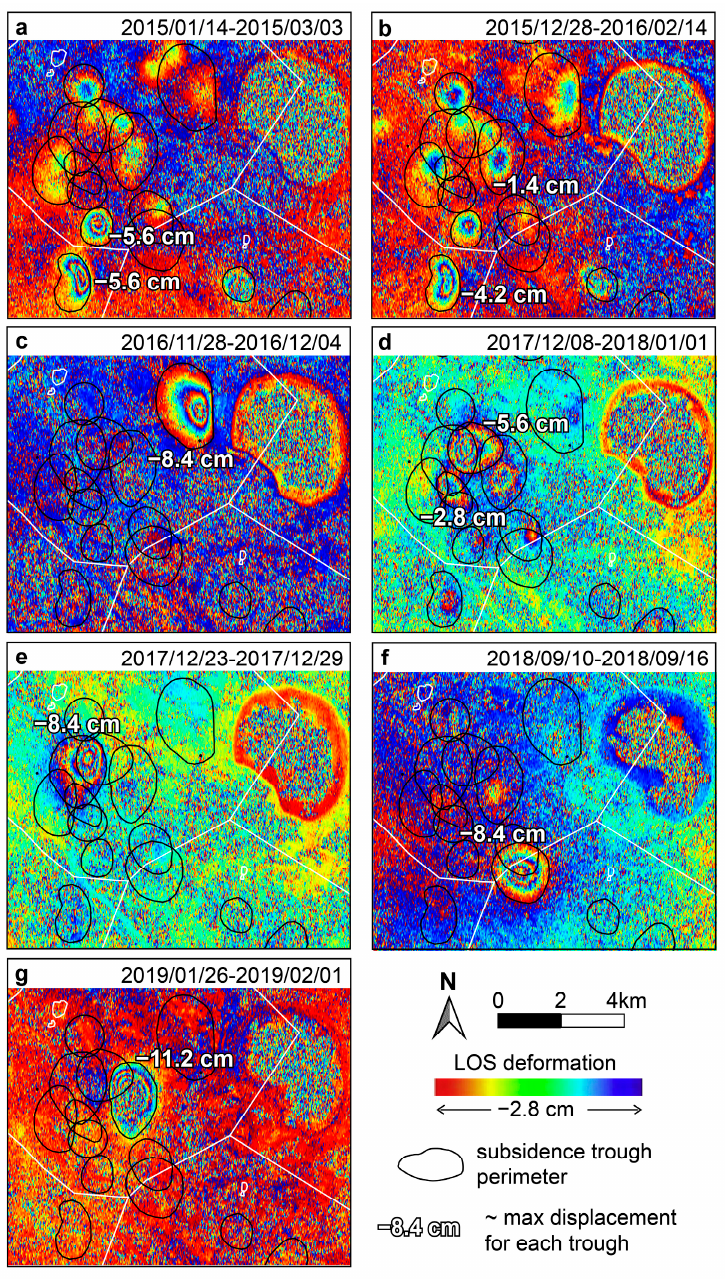
Figure 6. Interferograms subsets of the central part of the study area. Each interferometric fringe (color scale from blue to red) corresponds to a displacement of − 2.8